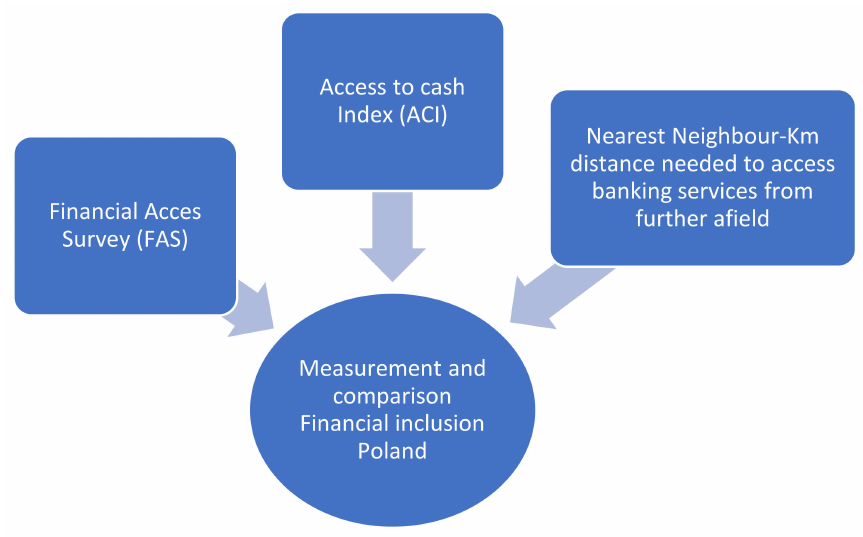
Figure 1. Methodology applied. Source: own